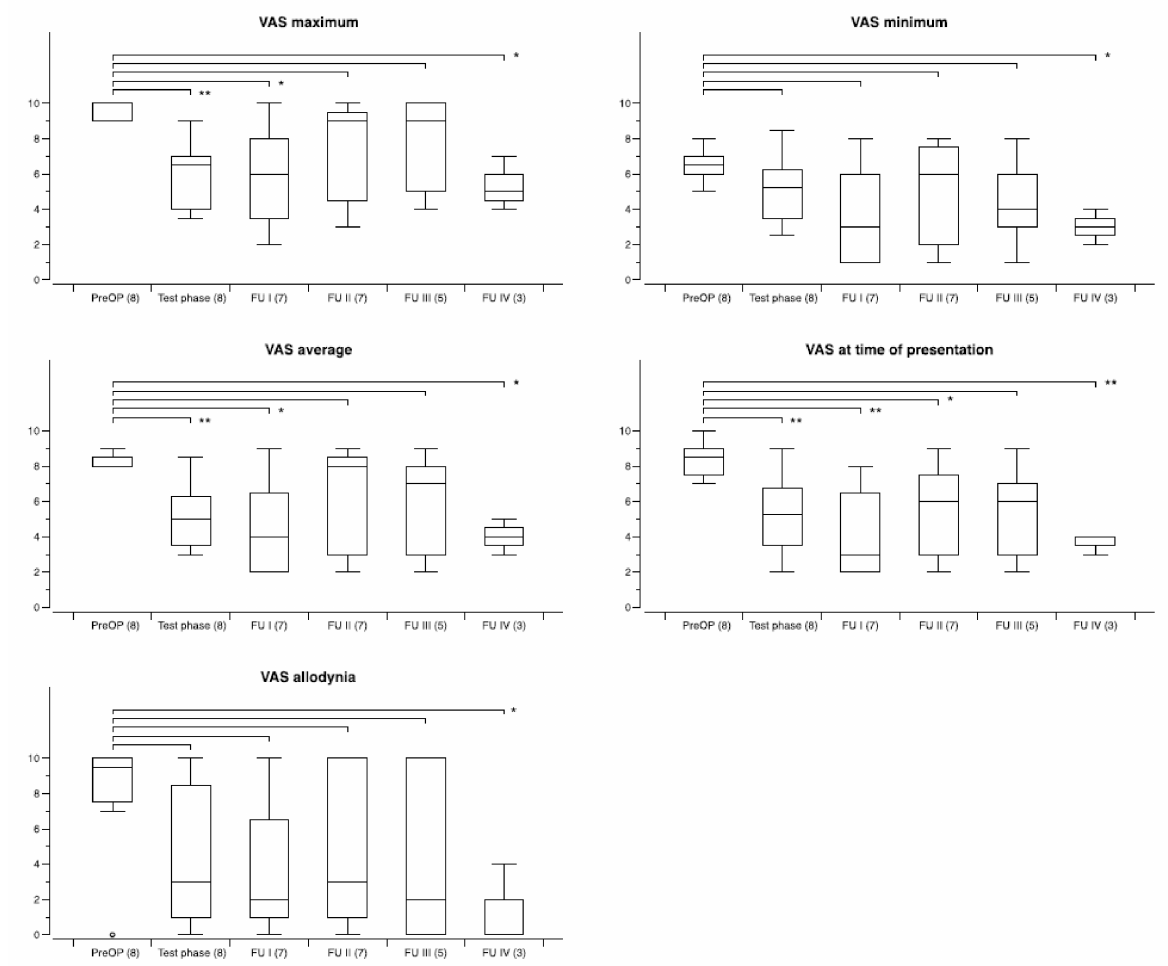
Figure 4. Development of specific VAS pain scores during chronic thalamic stimulation in a group of eight patients with CRPS. The number of patients available at the different time points is shown in brackets. Follow-up examinations were obtained at FU I: 3–12 months postoperatively, FU II: 12–23 months, FUP III: 24–47 months, and FU IV: 48-and longer. Box and whisker plots of test results over time. Boxes represent the first, second (mean), and third quartile of scores. Whiskers outline the maximum and minimum. The level of significance for the different follow-up periods as compared to preoperatively is indicated by * (* p < 0.05; ** p < 0.01; *** p <